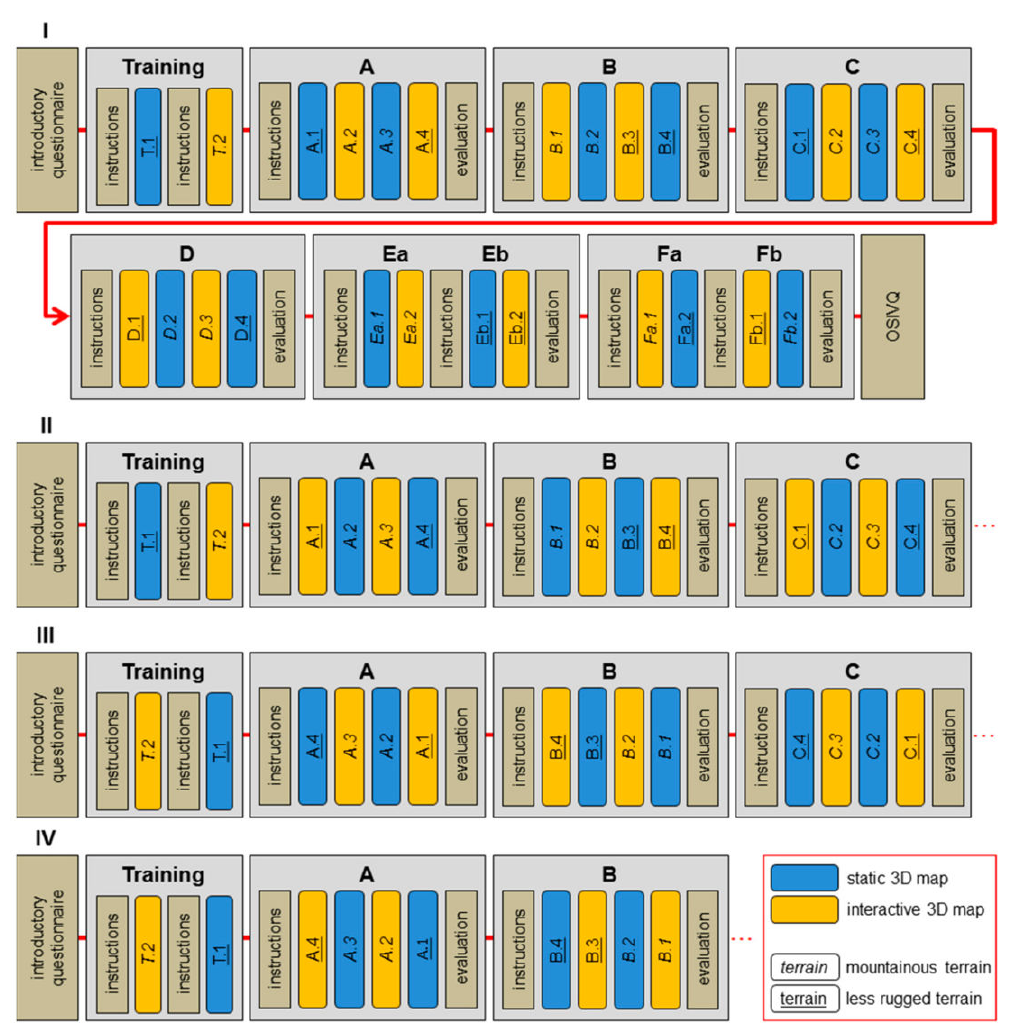
Figure 1. Design of the experiment (four versions of the test battery are marked as I, II, III, and